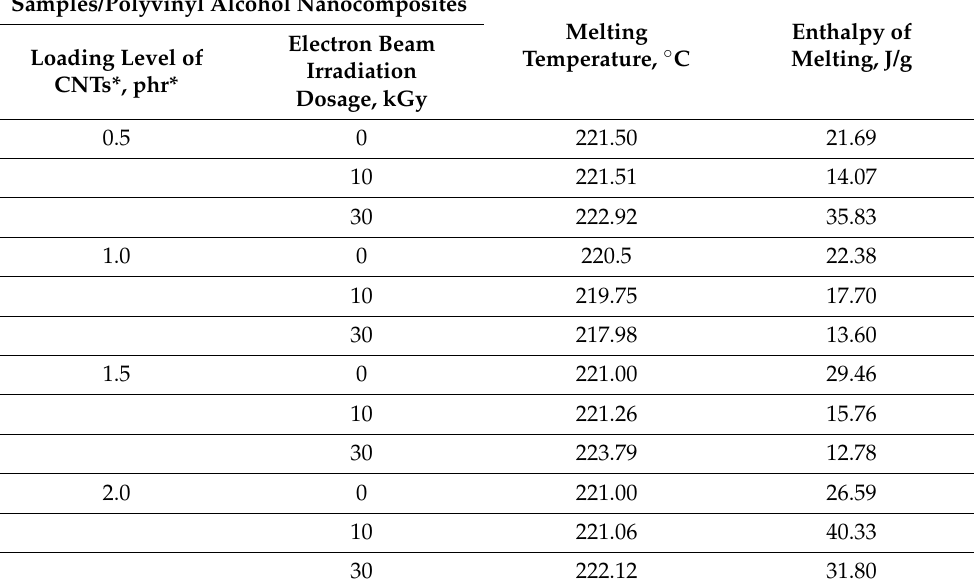
Melting Enthalpy of Temperature, ◦ C